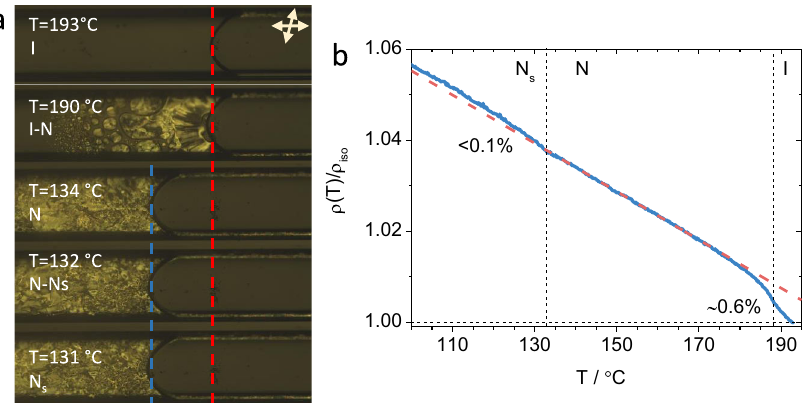
Fig. 7 Density changes measurements. a Polarizing optical microscopy snapshots at different temperatures of RM734 con fi ned in a 500 × 50 capillary showing the volume changes as a function of temperature. Top-right corner double arrows indicate the directions of the slightly uncrossed polarizer and analyzer. Dashed red and blue lines are visual guidelines and mark the meniscus position in the isotropic phase and in the N phase before transition to N S phase, respectively. b Solid blue line gives the measured temperature dependence of the normalised density. Dashed line is the linear extrapolation from the data in the N